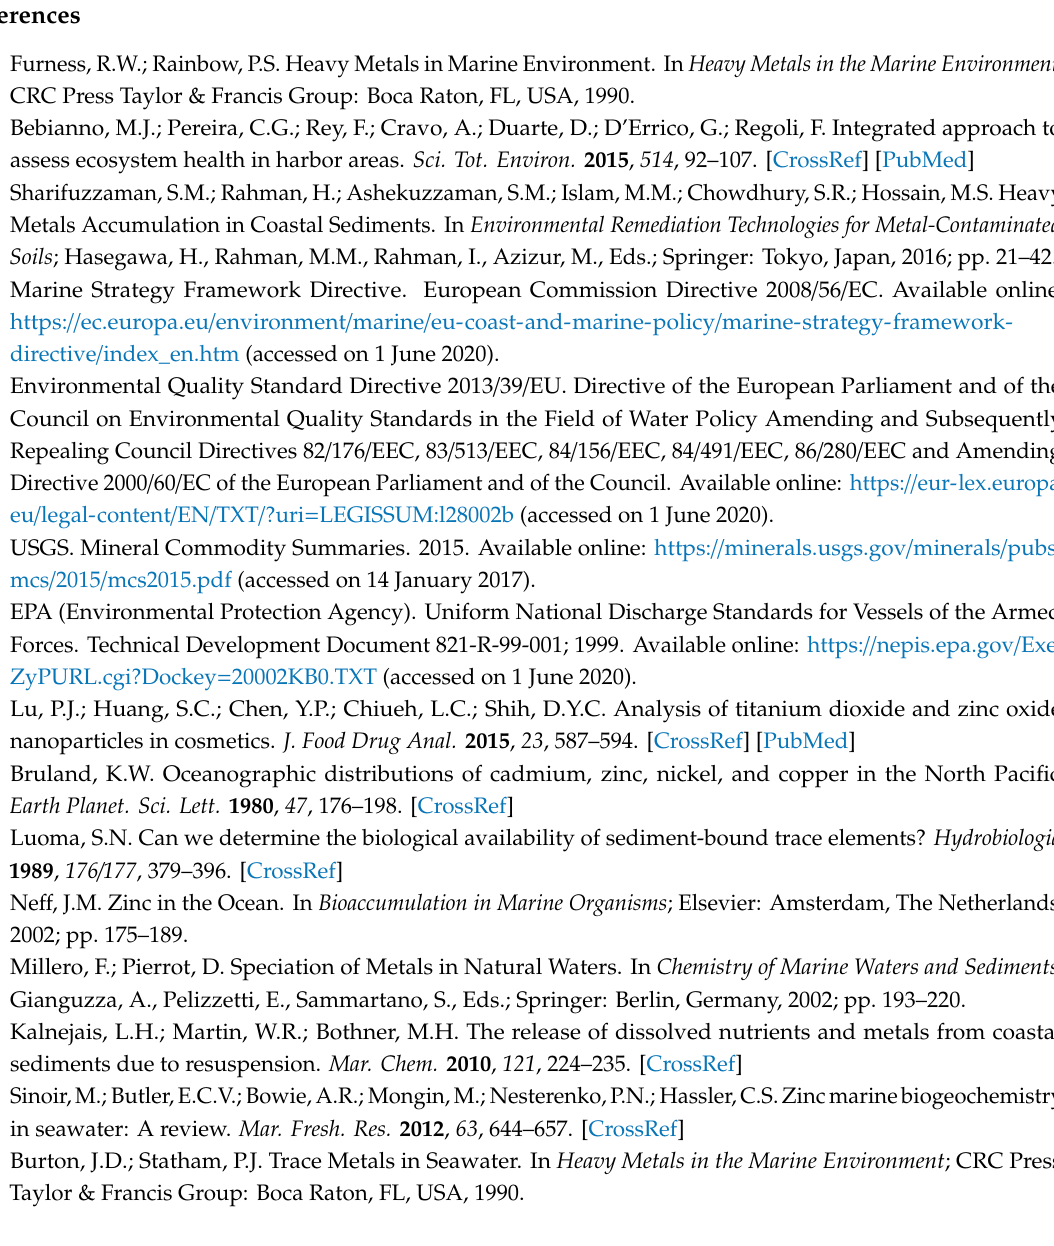
Table S1: pH levels in mussel’s exposure media. Figure S1: Lysosomal membrane destabilization in mussels exposed to ZnCl 2 ; Figure S2: Nuclear abnormalities detected in mussel’s gill cells; Figure S3: water exposure media filtered using 0.45 µ m cellulose filter